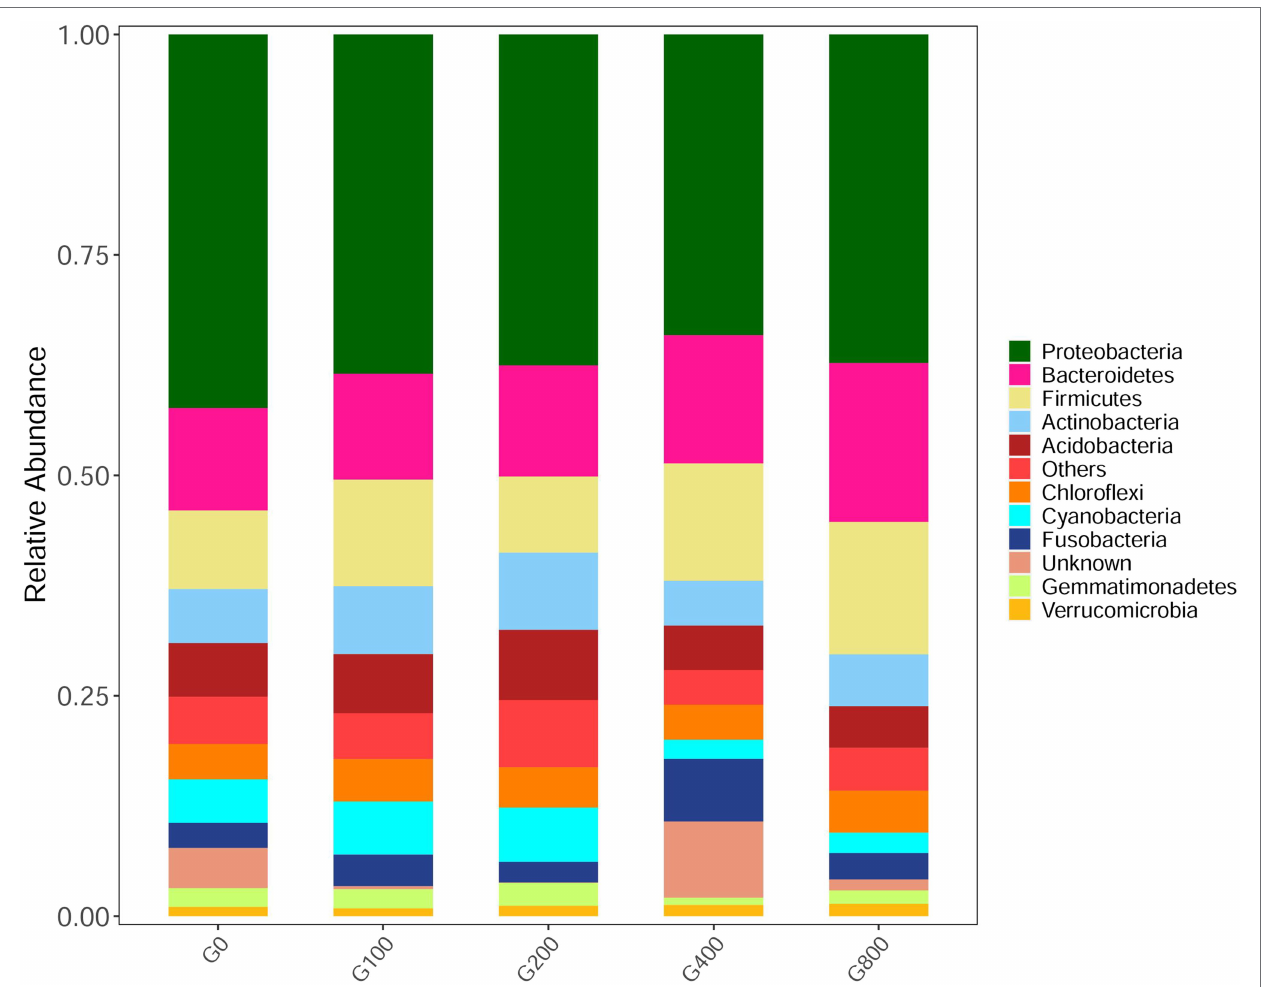
FIGURE 4 | Composition and relative abundance of bacterial community-based 16 S rDNA sequences in phylum level ( n = 3).